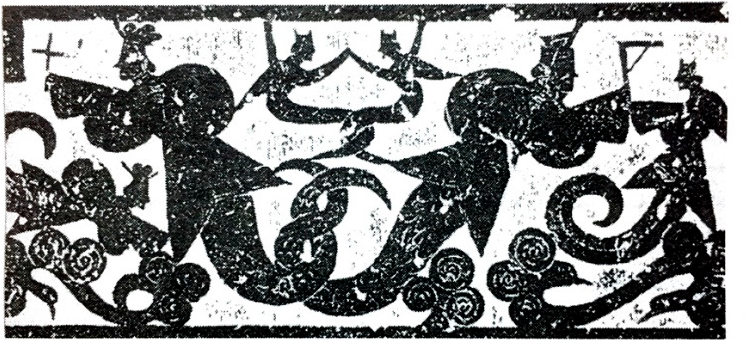
Figure 4. The Wuliangci’s tomb-shrine relief (the second century CE) shows that the legendary culture heroes Fuxi ( 伏 羲 , left) and Nuwa ( 女 媧 , right) hold a compass and an L-shaped try square manufactured in the Later Han